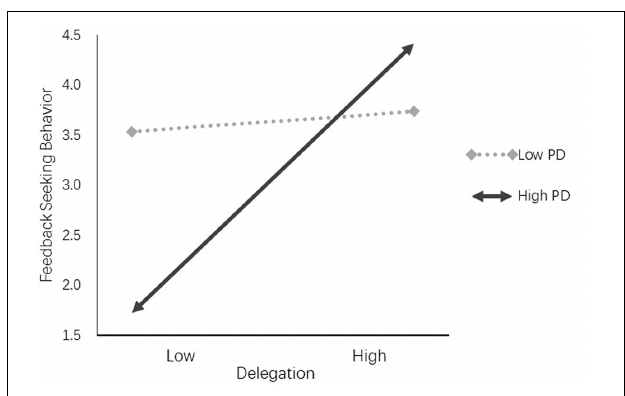
FIGURE 2 | Delegation and feedback seeking by power